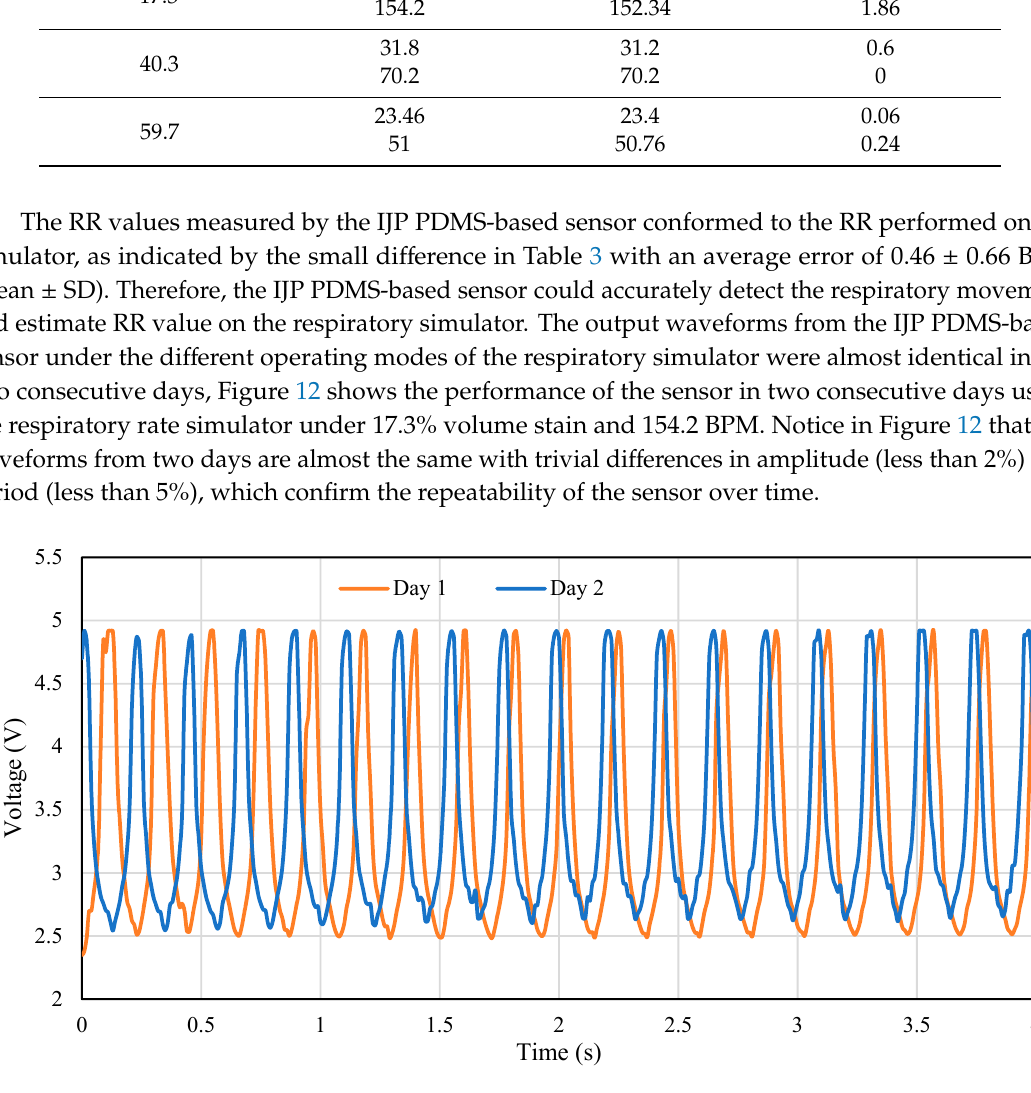
Table 4. The measured respiratory rate by IJP PDMS-based sensor compared with the actual one using the respiratory simulator at di ff erent volume strains.